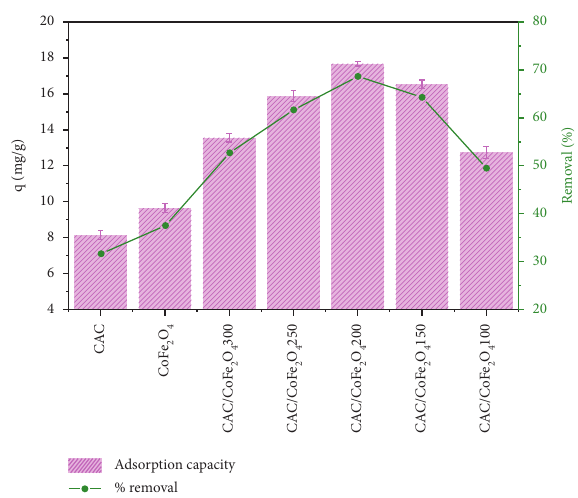
Figure 1: The effect of various molar ratios of Co: Fe:CAC on RhB adsorption at 50mg/L of initial Rhodamine B, 60 min of contact time, and 0.05g of adsorbent dosage/25mL